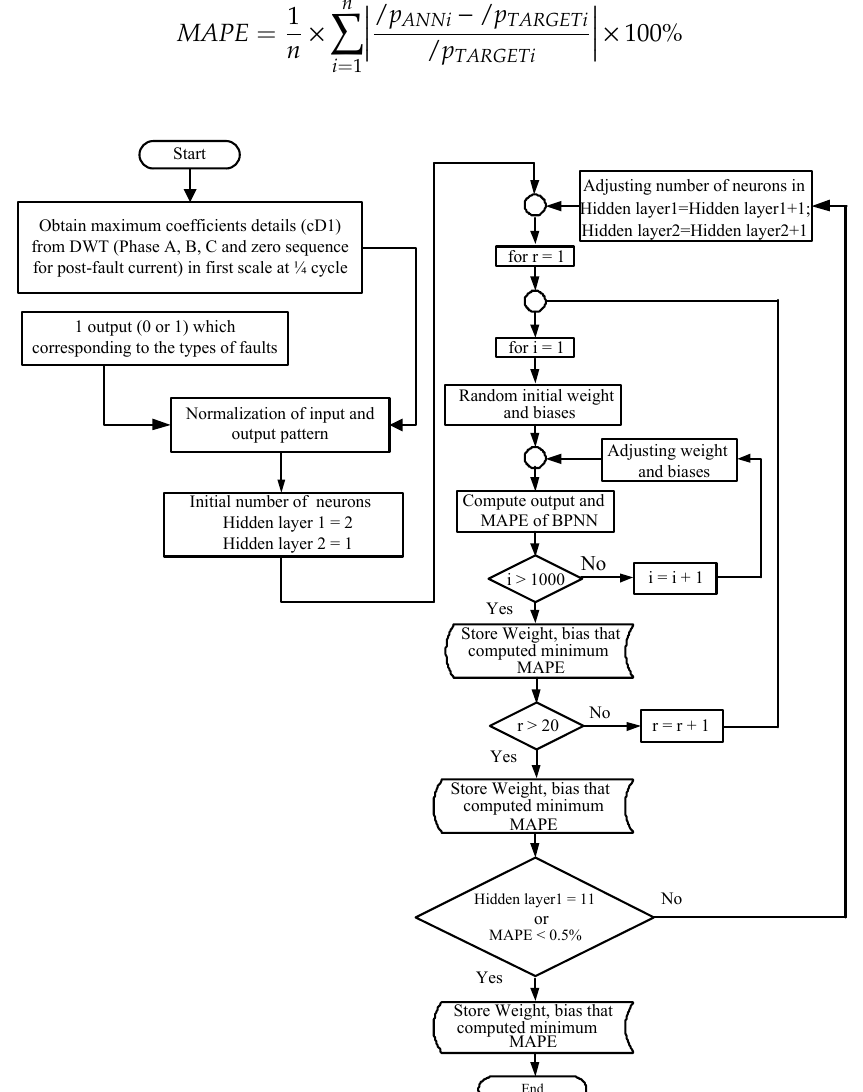
Figure 6. Training process of the back-propagation neural network (BPNN).